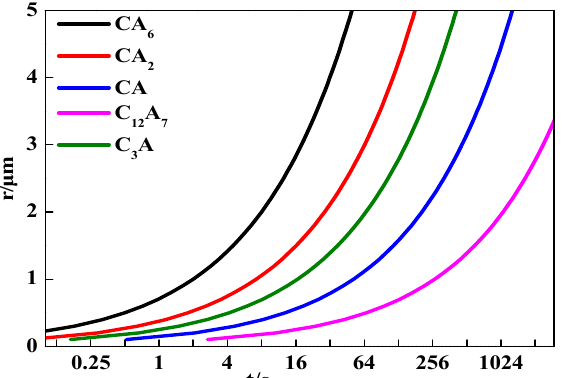
Figure 12. Complete modification time for Al 2 O 3 inclusions of different sizes.